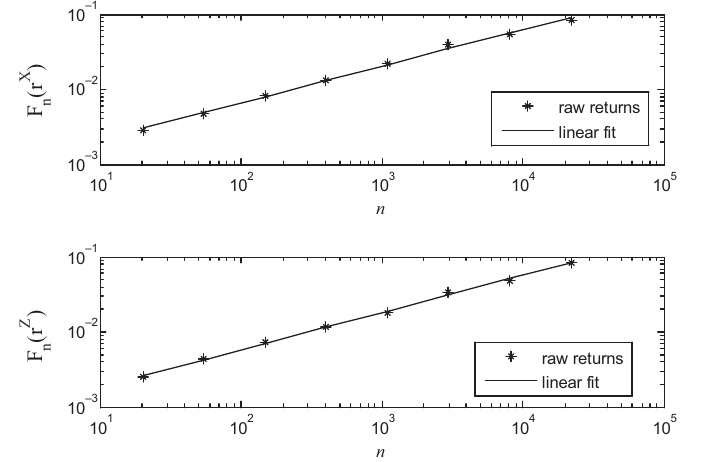
Figure 7. Estimation of self- similarity parameter